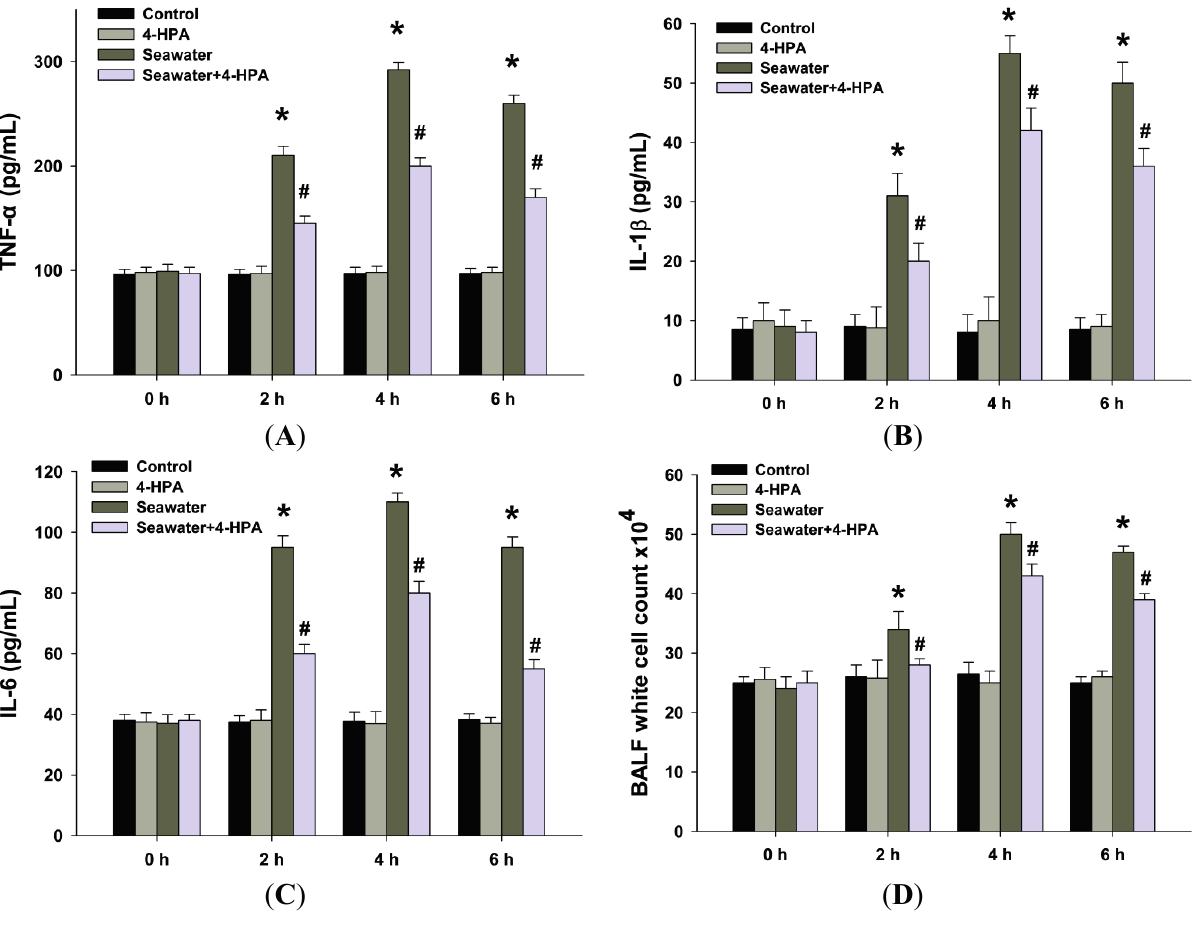
Figure 3. Effects of 4-HPA on inflammatory cytokines, vascular leakage, and edema after seawater instillation in lungs. After instillation of seawater for 0, 2, 4, and 6 h in the absence or presence of 4-HPA, TNF- α ( A ); IL-1 β ( B ); and IL-6 ( C ) contents in lung tissues were assessed by ELISA and white cells in brochoalveolar lavage fluid (BALF) were counted ( D ); Pulmonary vascular leakage was determined by Evans blue dye analysis ( E ); Lung edema was assessed by wet to dry weight ratios ( F ); Lung tissues were stained with hematoxilin and eosin to reveal histopathological changes at 4 h after seawater aspiration. ( G ) Control group; ( H ) 4-HPA group; ( I ) Seawater group; and ( J ) Seawater + 4-HPA group. The data are presented as means ± SD from three independent